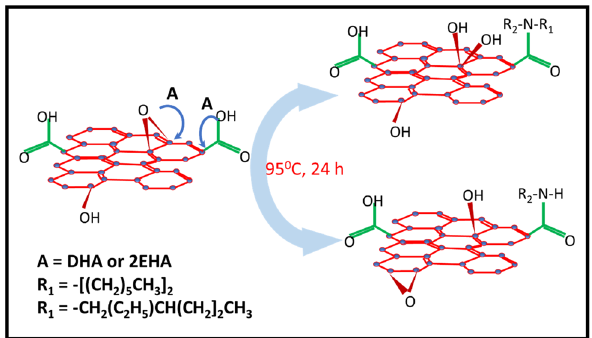
Figure 18: Schematic of the mechanism proposed for the binding of DHA and 2EHA onto